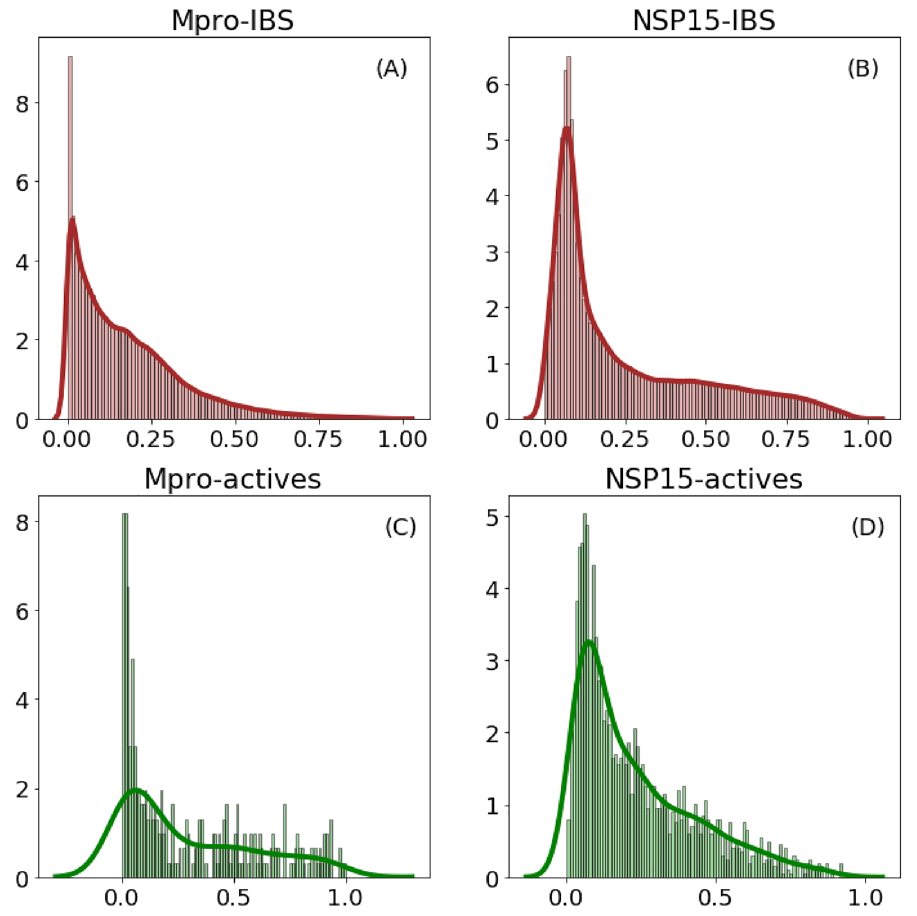
Pro and NSP15 as targets. ( A , B ) correspond Pro targets against IBS molecules. ( C , D ) correspond to Pro and NSP15 respectively (for each plot, the x-axis